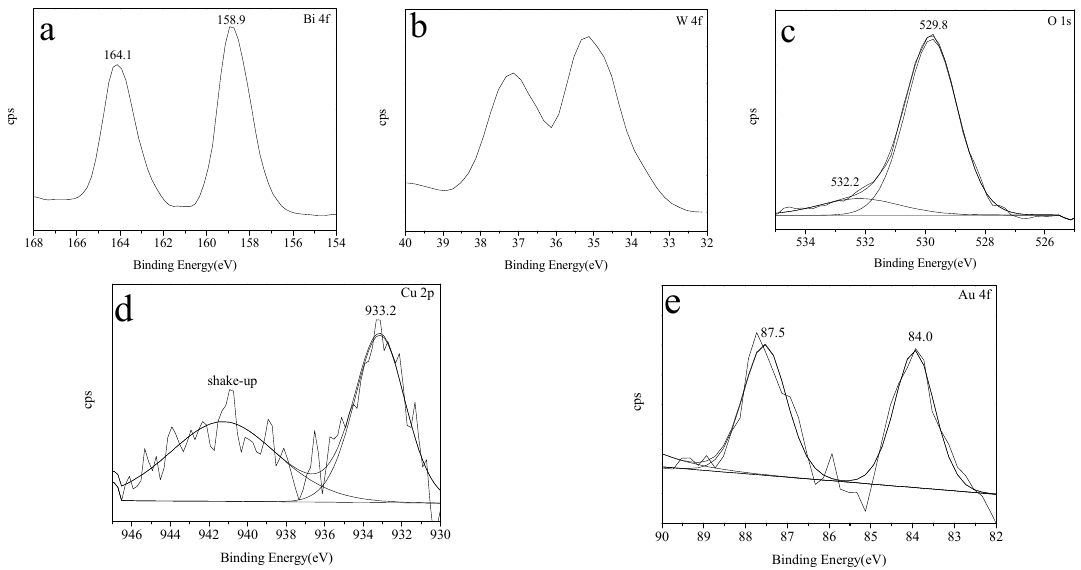
Figure 5. XPS spectra of Au–CuO/Bi 2 WO 6 -400 (Cu 4.85 wt %, Au 0.438 wt %): Bi 4f peaks ( a ); W 4f peaks ( b ); O 1s peaks ( c ); Cu 2p peaks ( d ); Au 4f peaks ( e ).